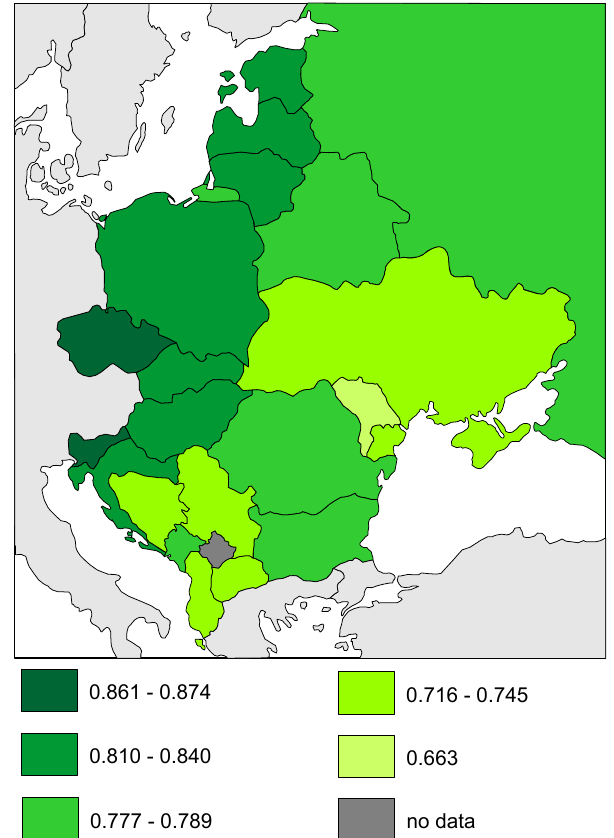
Fig. 3. Human Development Index values in European post-Communist countries in 2013 (source: